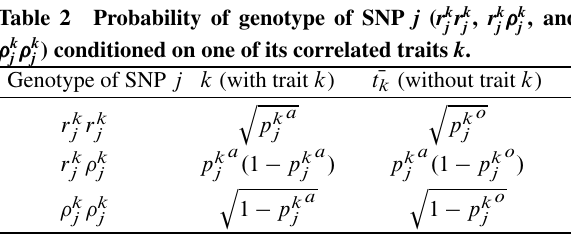
(cid:26)(cid:26)(cid:26) k r k , r k , and j j j j